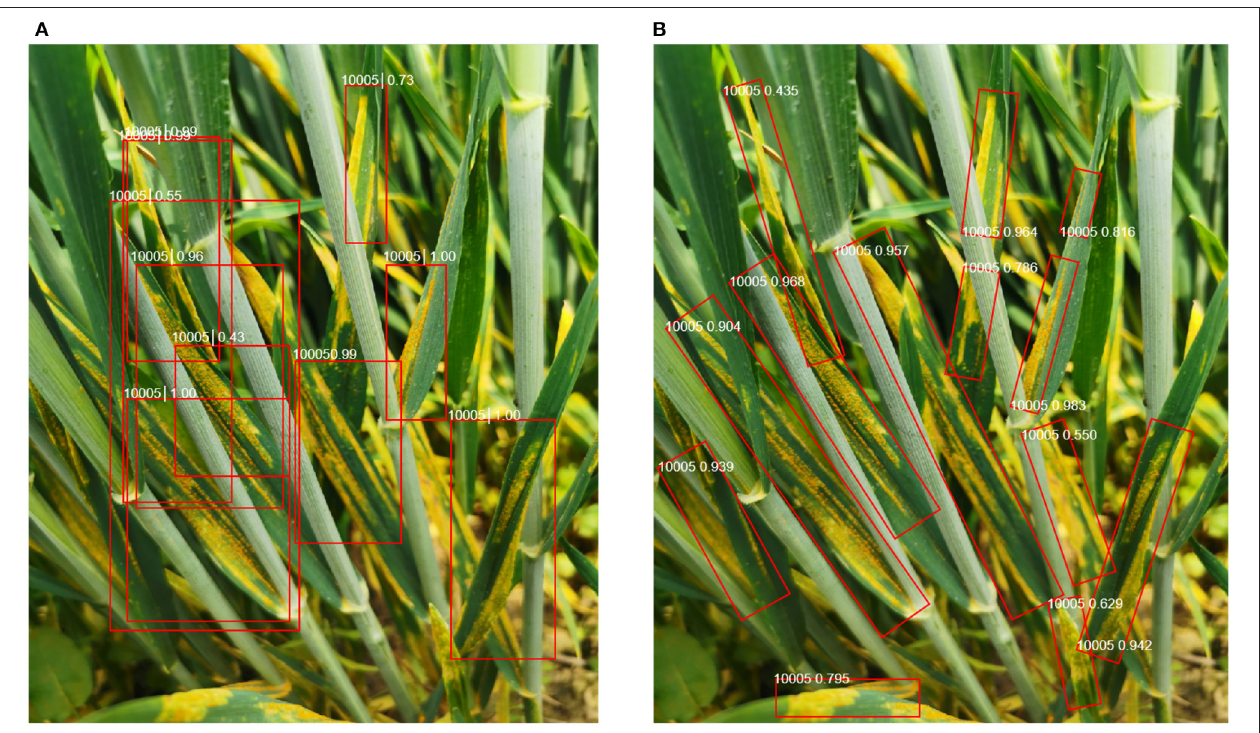
FIGURE 1 | Comparison of horizontal object detection and oriented object detection results. (A) Horizontal object detection and (B) oriented object